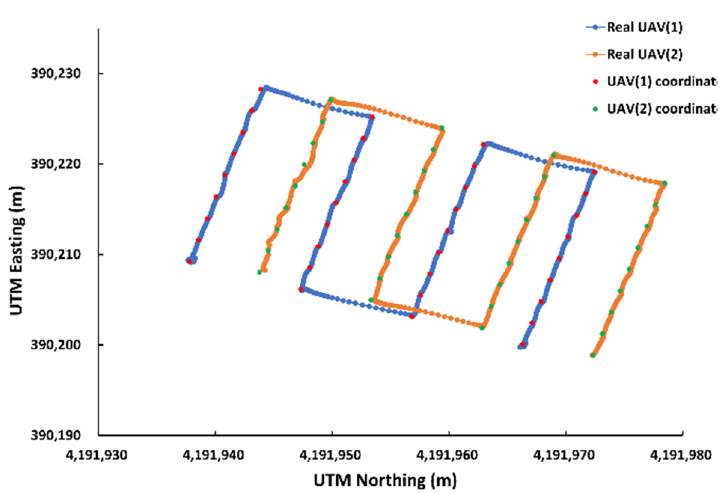
Figure 20. Flight trajectories obtained from the two UAVs in the actual field. Table 5. Flight performance comparison of simulation and actual field results.